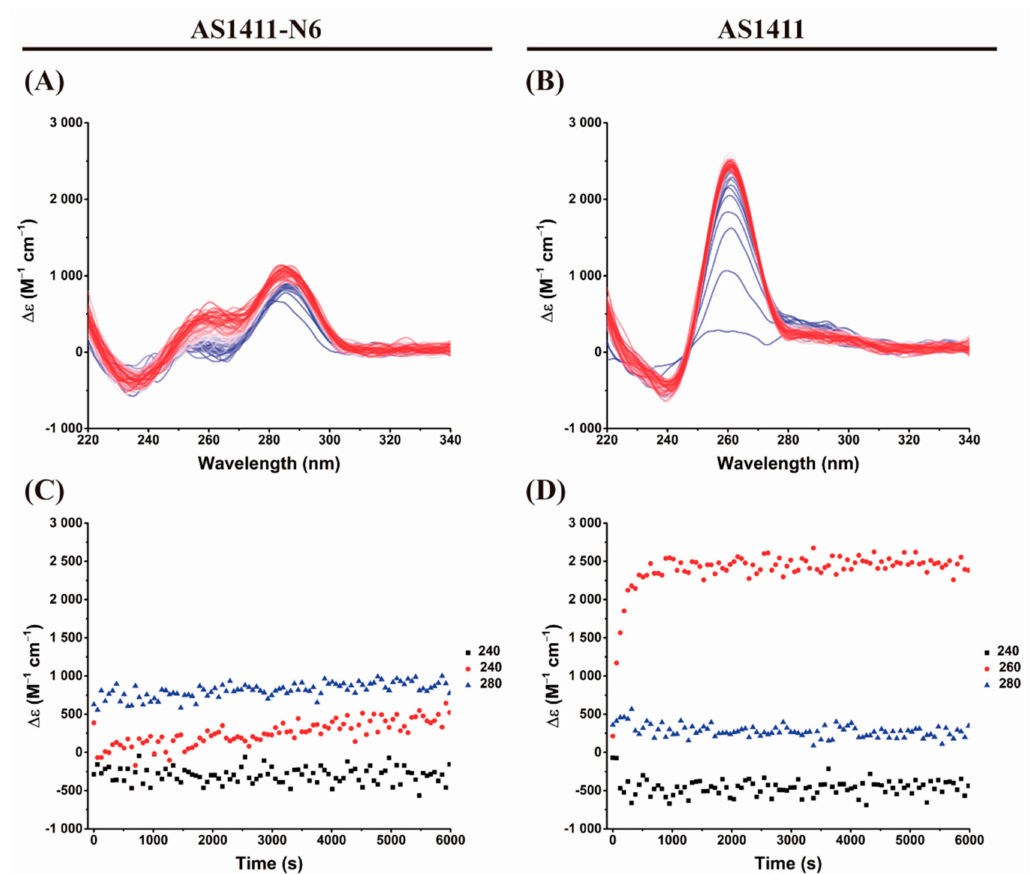
Figure 3. Time-dependent CD experiments of ( A ) AS1411-N6 and ( B ) AS1411 after the addition of 20 mM of KCl. Plots of the time-dependence of three characteristic bands ( C ) AS1411-N6 and ( D ) AS1411. The transition from blue to red represents the time evolution of the CD signal for characteristic